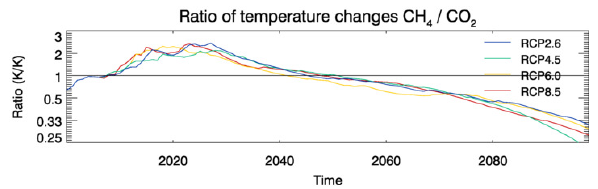
Figure 8. Time series of the median of the ratio of the proportion of P-GMT caused by CH 4 to that caused by CO 2 .